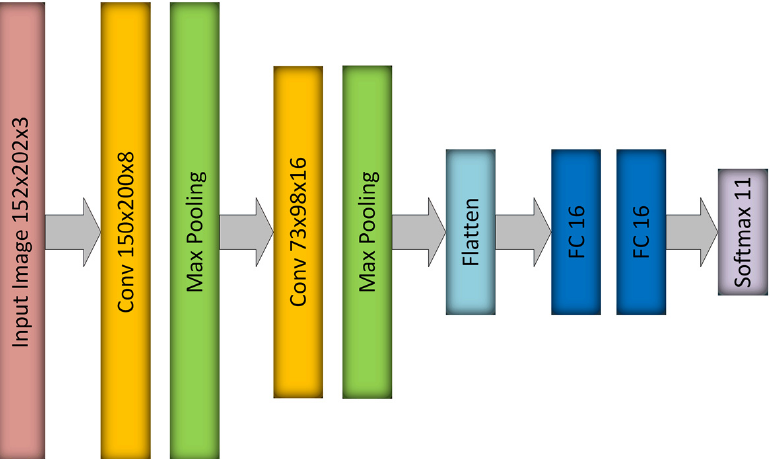
Figure 3. Baseline model.